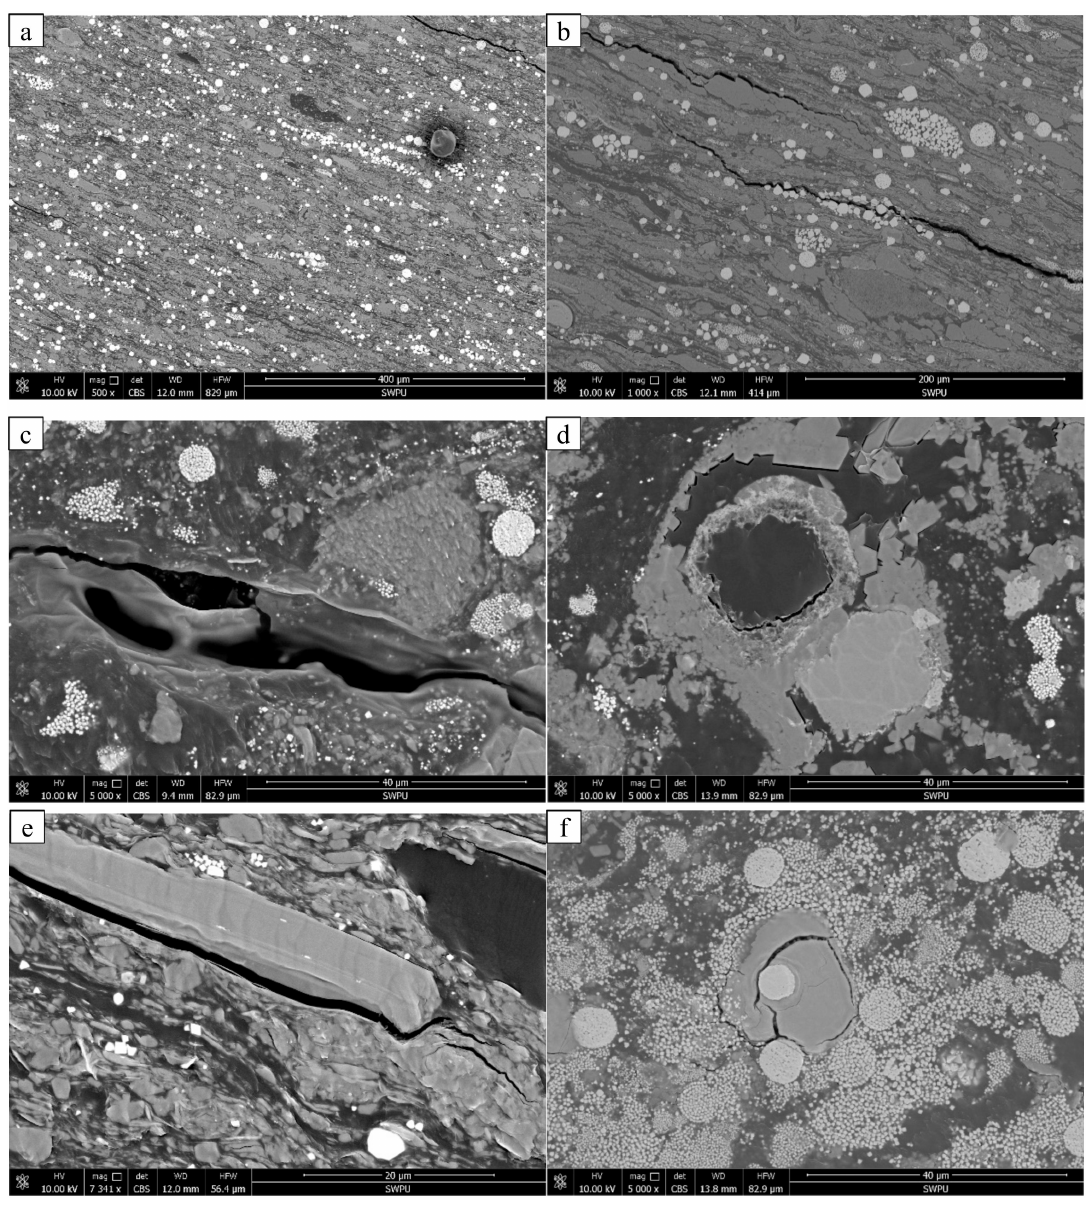
Figure 14. Cracks under scanning electron microscopy. ( a ) the distribution and arrangement of minerals are consistent with the direction of bedding; ( b ) cracks developed in parallel bedding directions; ( c ) corrosion cracks, 800–3000 nm; ( d ) edge cracks of organic matter and minerals, 500–600 nm; ( e ) edge cracks of minerals, 1–2 µ m; ( f ) internal cracks of minerals, 400–600